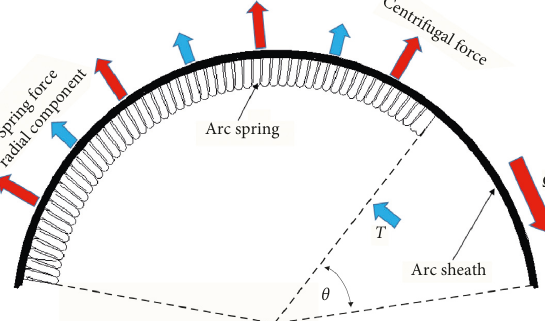
Figure 1: Arc spring DMF.